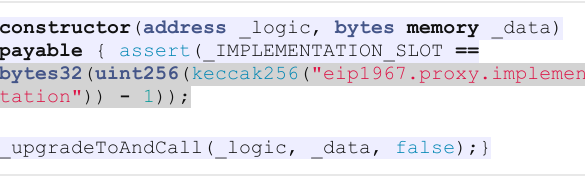
Figure 3. The Upgrade process of Upgrade function